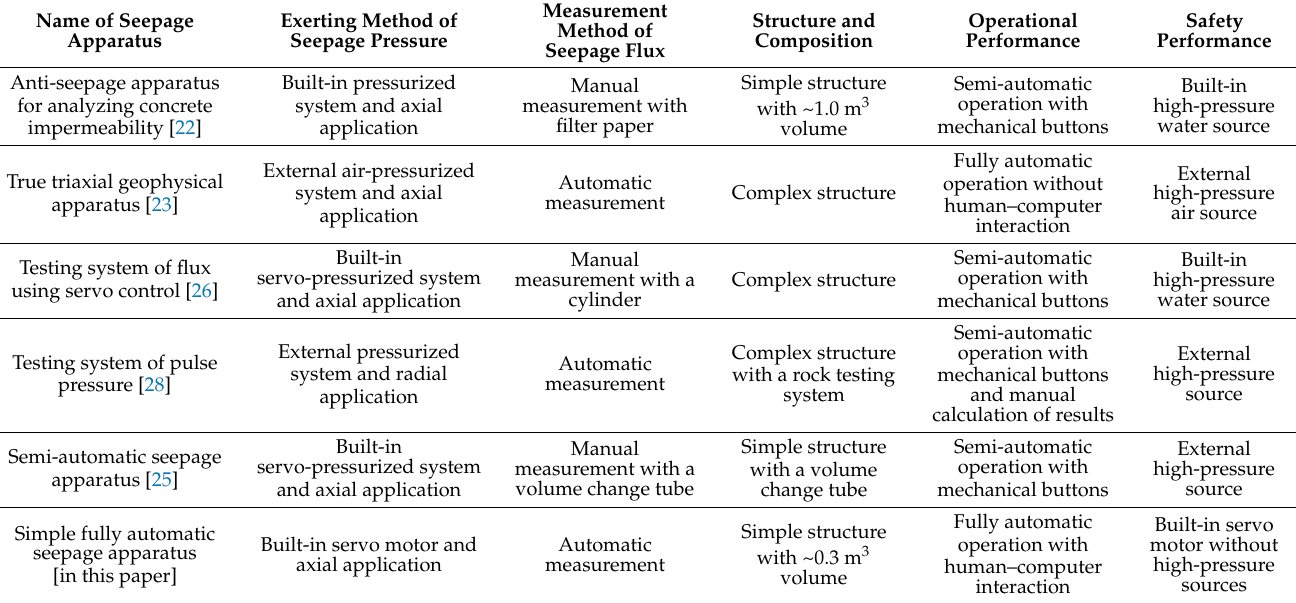
Table 7. Comparison results among the main seepage devices for low-permeability